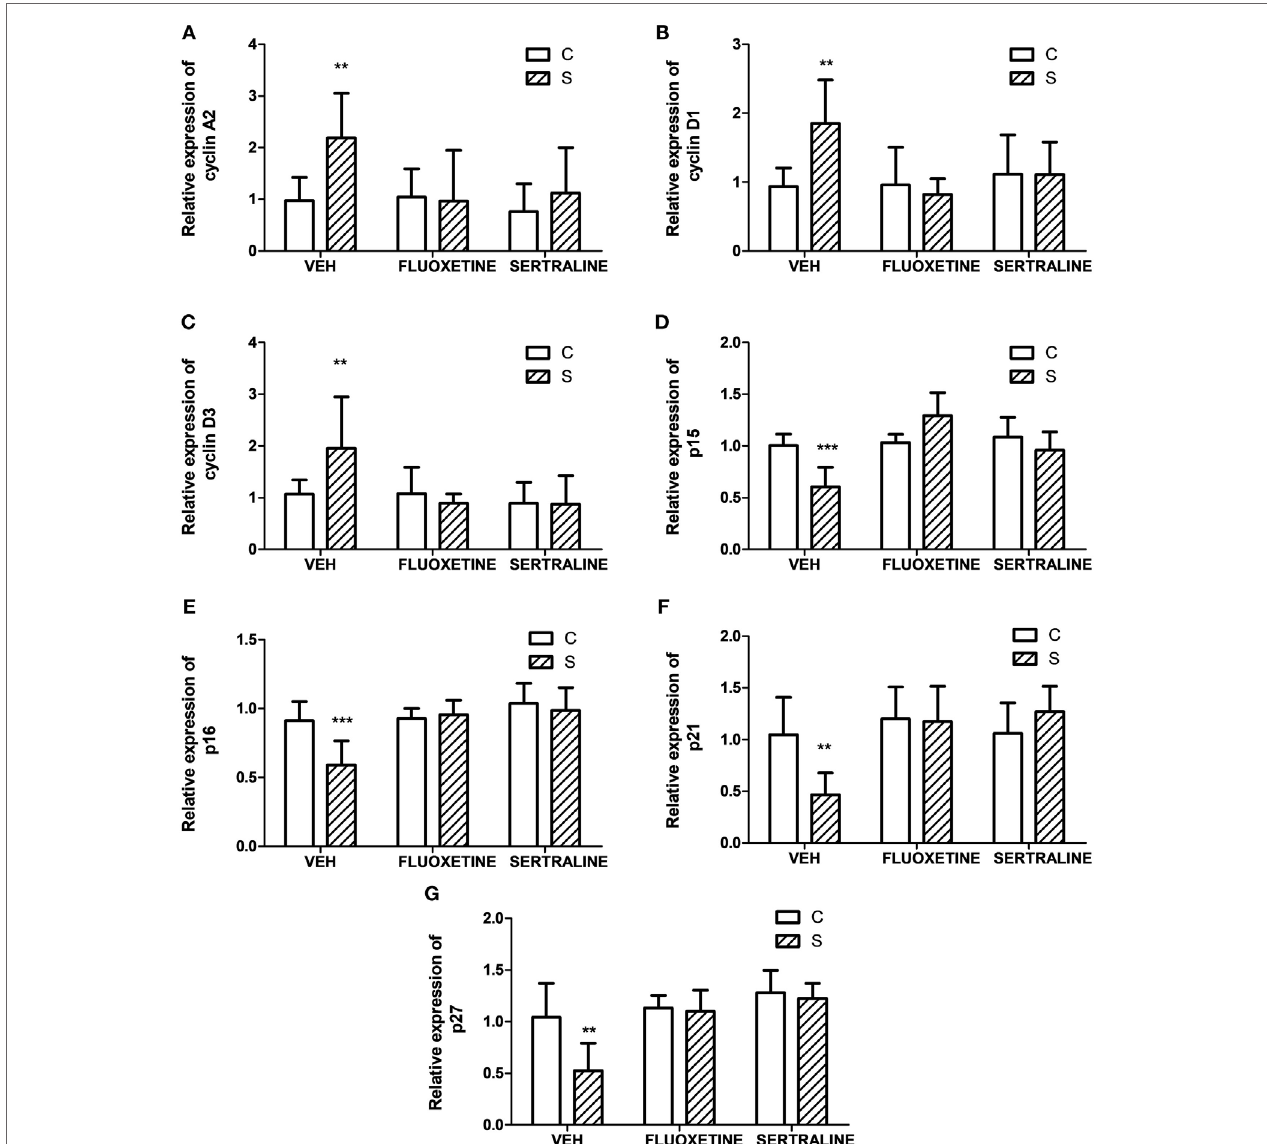
FigUre 2 | Effect of chronic stress on the expression of proteins associated with cell cycle progression. Action of fluoxetine or sertraline treatment. Quantitative real-time reverse transcription polymerase chain reaction was performed in cDNA obtained from solid tumors excised 14 days post EL4 cells inoculation. (a) Cyclin A2, (B) D1, (c) D3, CDKIs (D) p15/Ink4b, (e) p16/Ink4a, (F) p21/Cip1, and (g) p27/Kip1 mRNA relative expression was quantified using β 2 -microglobulin as housekeeper. Values are expressed as mean ± SEM. n = 6 mice per group. ** p < 0.01, *** p < 0.001 respect to control